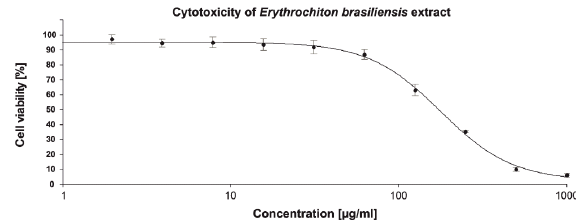
Figure 5: Cytotoxicity of Erythrochiton brasiliensis extract (Ebo).